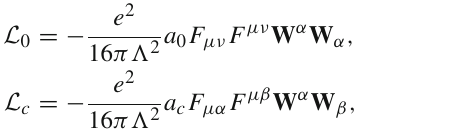
derivatives of the Higgs field is given by D μ (cid:8) = (∂ μ